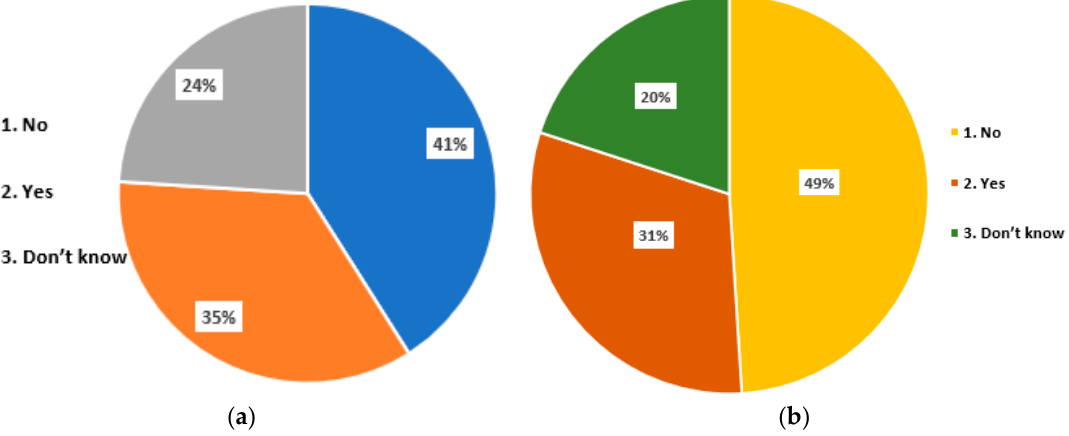
Figure 8. ( a ) Device Registration Via Email; ( b ) Downloading Apps from App-stores.